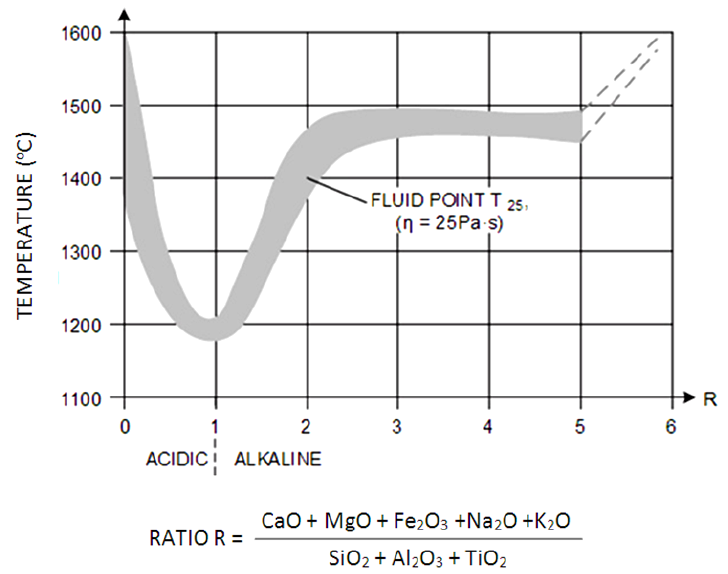
) versus base-acid ratio 25